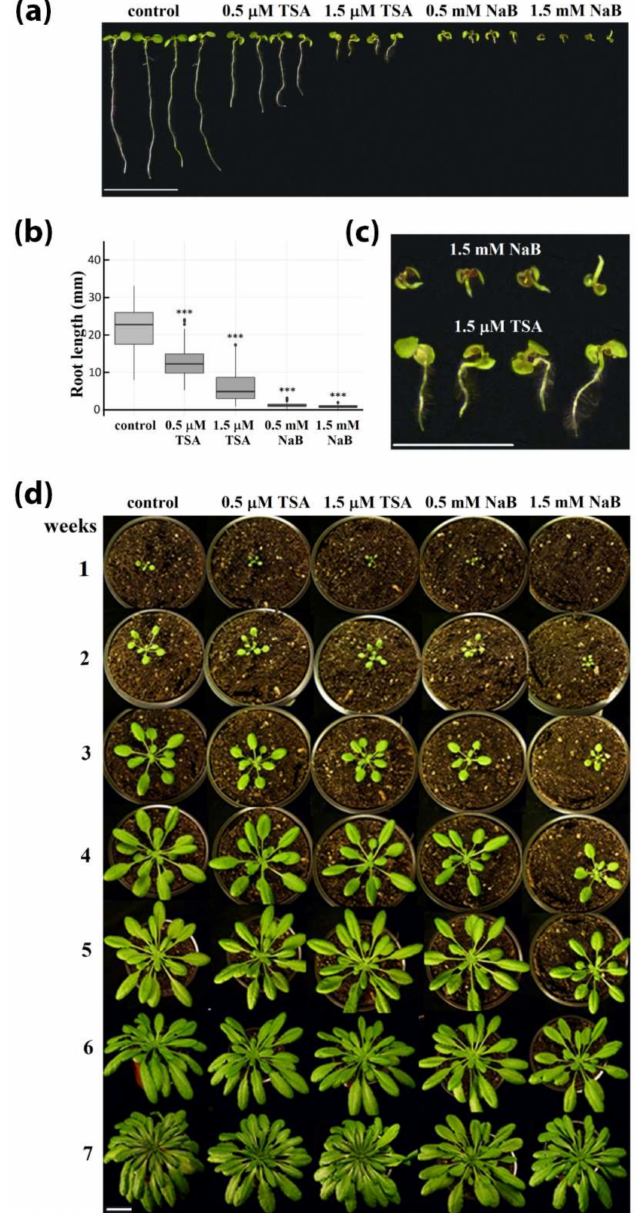
Figure 1. E ff ect of histone deacetylase (HDA) inhibitors on Arabidopsis growth and development. ( a ) Morphology of 7-day-old seedlings germinated in the presence of di ff erent concentrations of HDA inhibitors. Bar = 1 cm. ( b ) Lengths of primary roots in control and HDA inhibitor-treated seedlings. The box-plots show extremes, interquartile ranges and medians ( n = 30). Statistically significant di ff erences corresponding to p < 0.001 are marked by asterisks. ( c ) Detail of morphology of 7-day-old seedlings germinated in the presence of 1.5 mM NaB or 1.5 µ M TSA. Bar = 0.5 cm. ( d ) Phenotype recovery of plants germinated in the presence of HDA inhibitors during the cultivation in the soil. Bar = 2